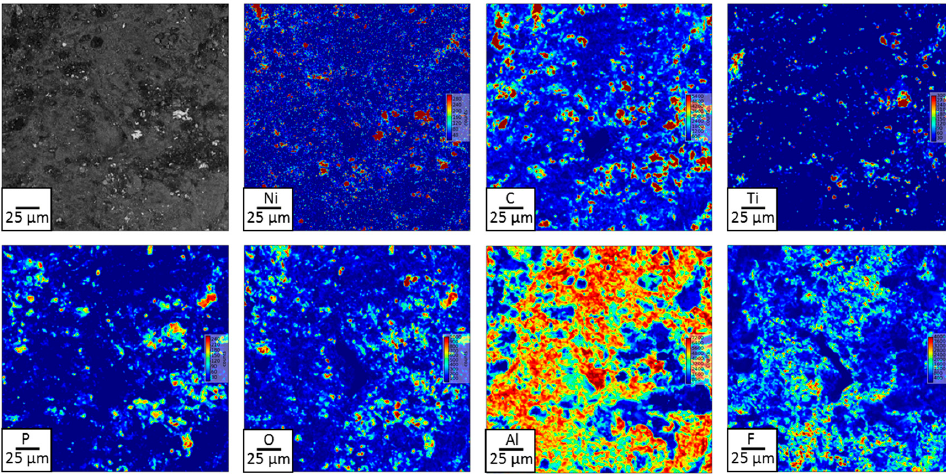
Figure 6. Aluminum foil after microwave (MW) treatment (MW 501 °C): presence of main elements in the surface (electron probe micro-analyzer, EPMA).